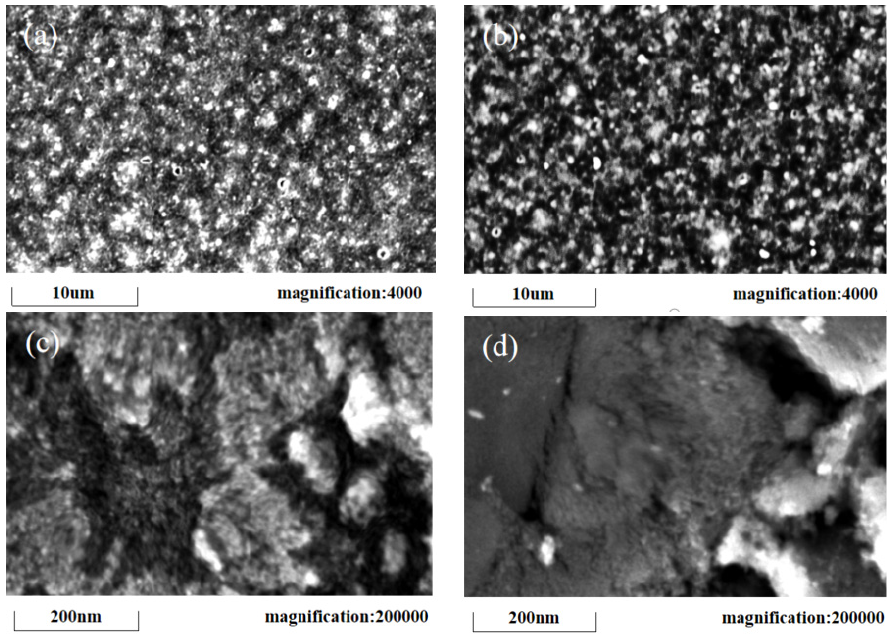
Figure 7. SEM of TiO 2 films on different electrode surfaces: ( a ) FTO surface, 4000 times magnification; ( b ) stainless steel surface, 4000 times magnification; ( c ) FTO surface, 200,000 times magnification; ( d ) stainless steel surface, 200,000 times magnification.